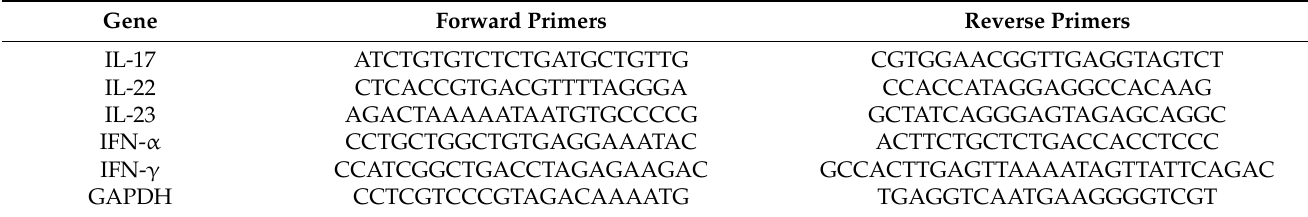
Table 1. The sequences of